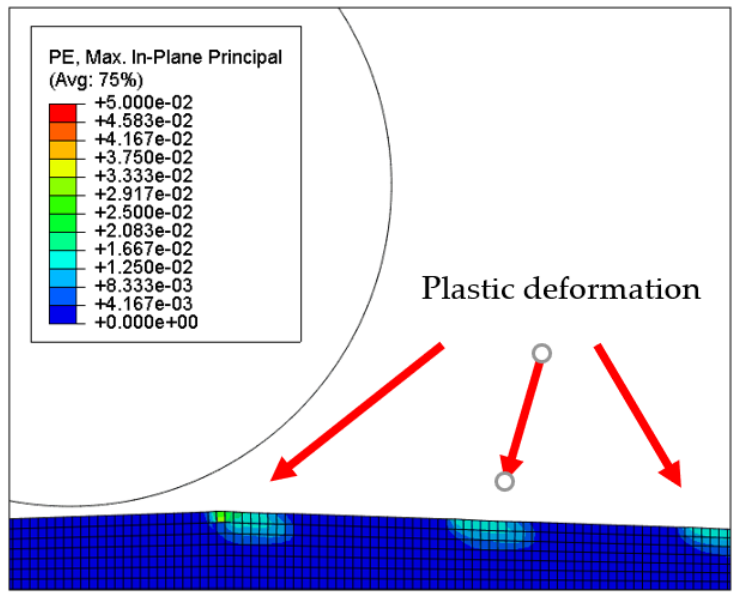
Figure 9. Plastic strain map of the 1000 nm high tool mark surface.